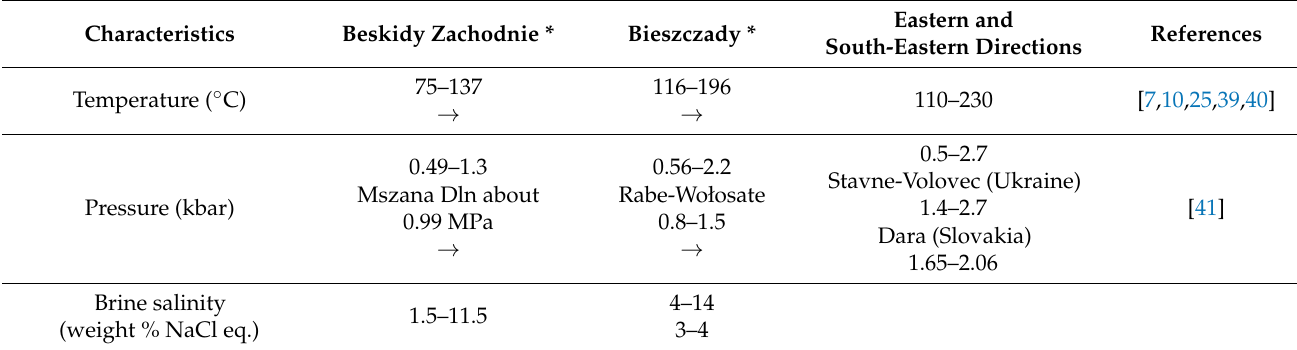
Table 4. Variation in temperature, pressure and brine salinity in the area of the Polish part of the Carpathians and outside Polish frontiers.